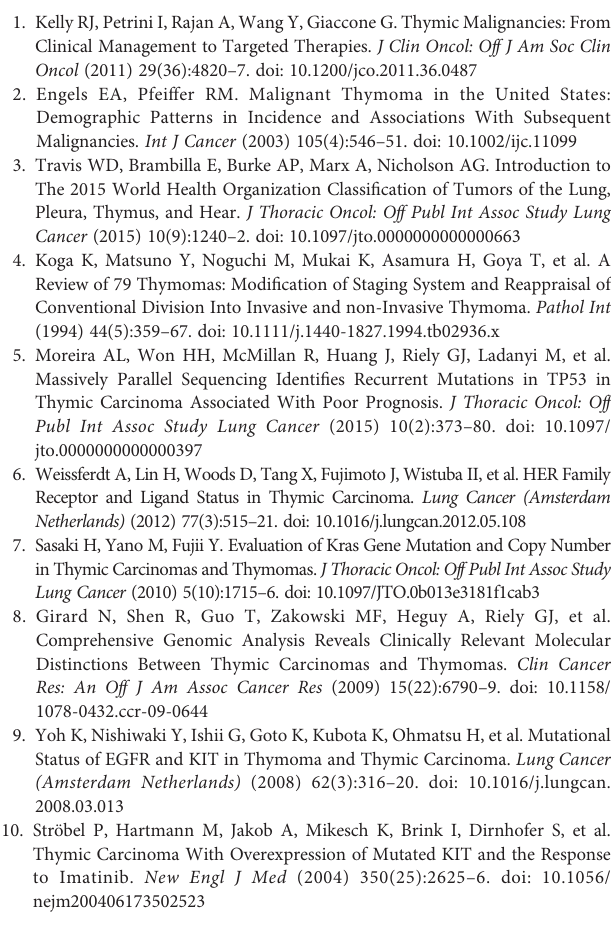
Supplementary Table 2 | The gene somatic mutation distribution of TCGA all types of TETs patients. Supplementary Table 3 | The gene somatic mutation distribution of TCGA type B3 and C patients. Supplementary Table 4 | The gene somatic mutation distribution of TCGA non- B3 and C